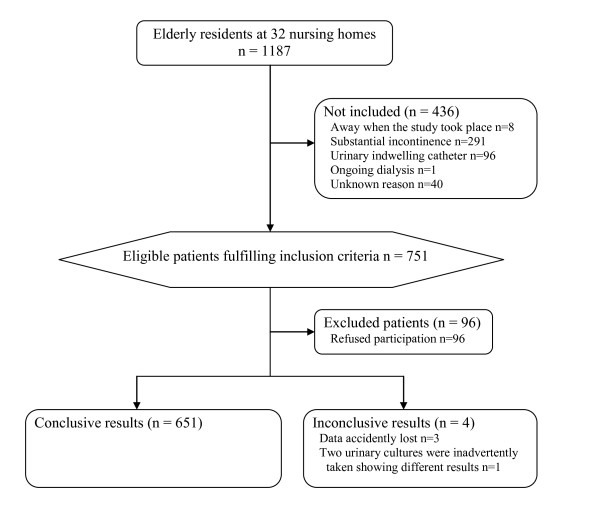
Participents Flow Chart